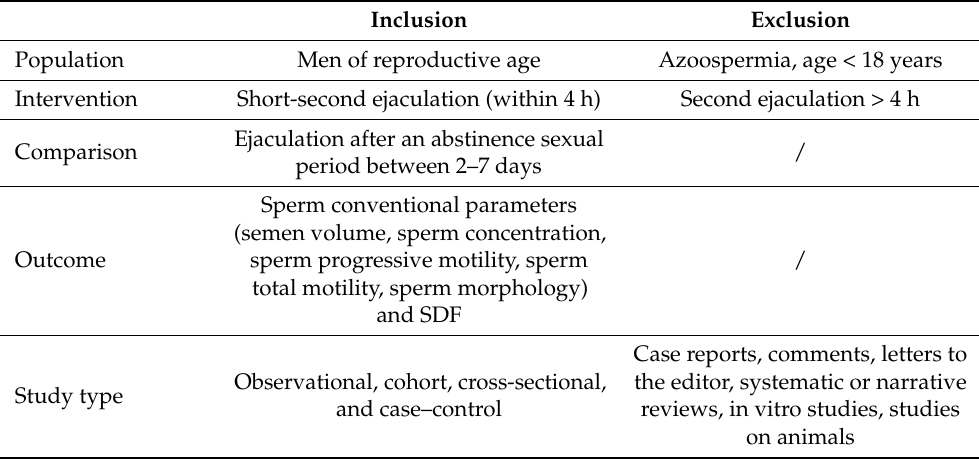
Selection criteria in included studies (PICOS) (Population, Intervention, Compari- son/Comparator, Outcomes, Study design) model of the current systematic review and